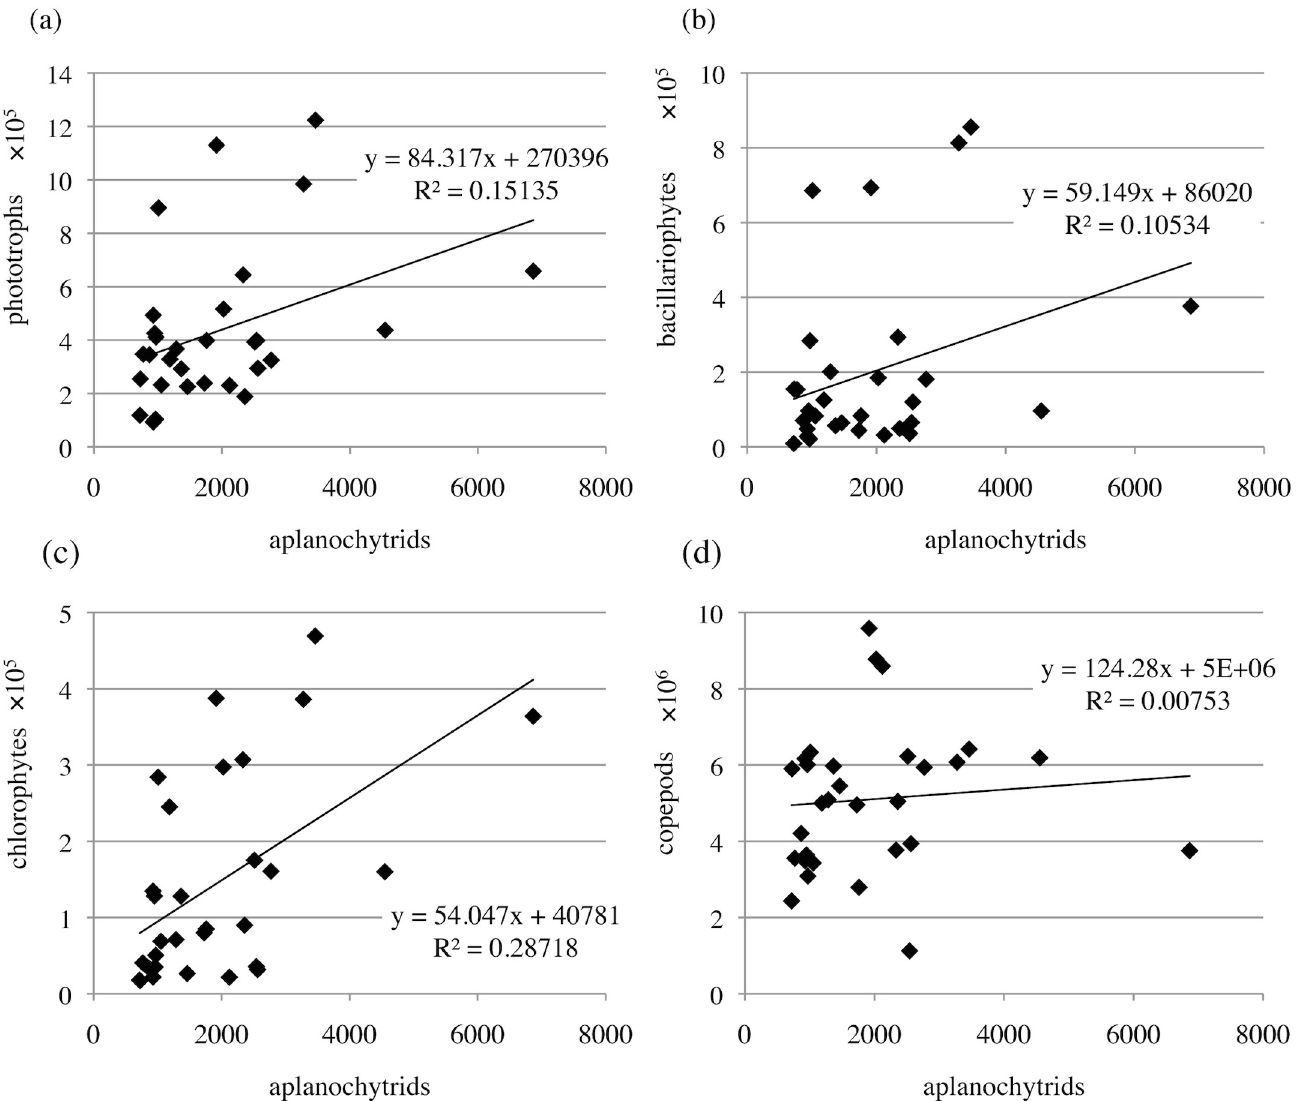
Fig 11. Correlations between Aplanochytrium and prey/predators. (a) Phototrophs excluding dinoflagellates. (b) Bacillariophytes. (c) Chlorophytes. (d)